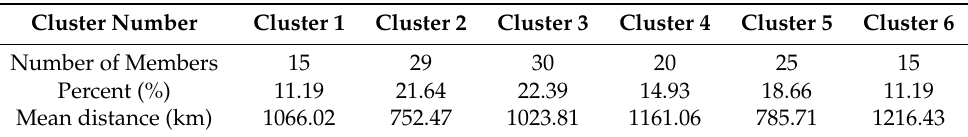
Table 2. The numbers and percentages of TCs that were grouped into the six different clusters by their tracks. The mean distances of all clusters are also provided.